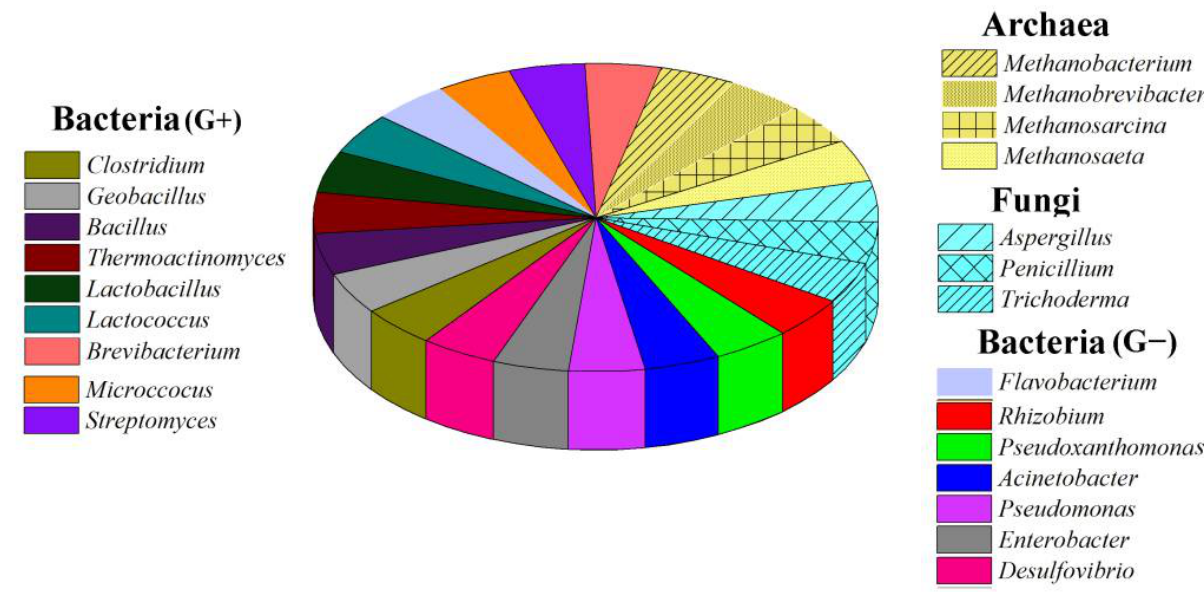
Figure 4. A palette of the most common microorganisms present in anaerobic consortia producing biogas, the action of which is a target for suppression by reagents. Table 5. Effect of various suppressors on the action characteristics of natural methanogenic consortia (biogas production, CH 4 content, and intracellular ATP